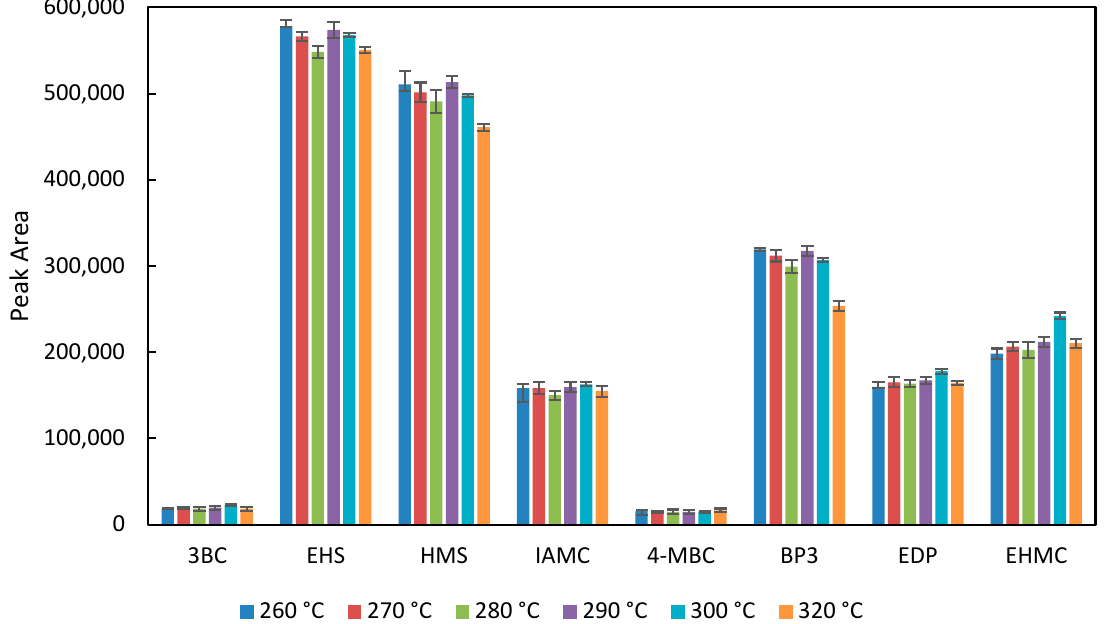
Figure 2. The effect of injection temperature on peak areas of UVFs.